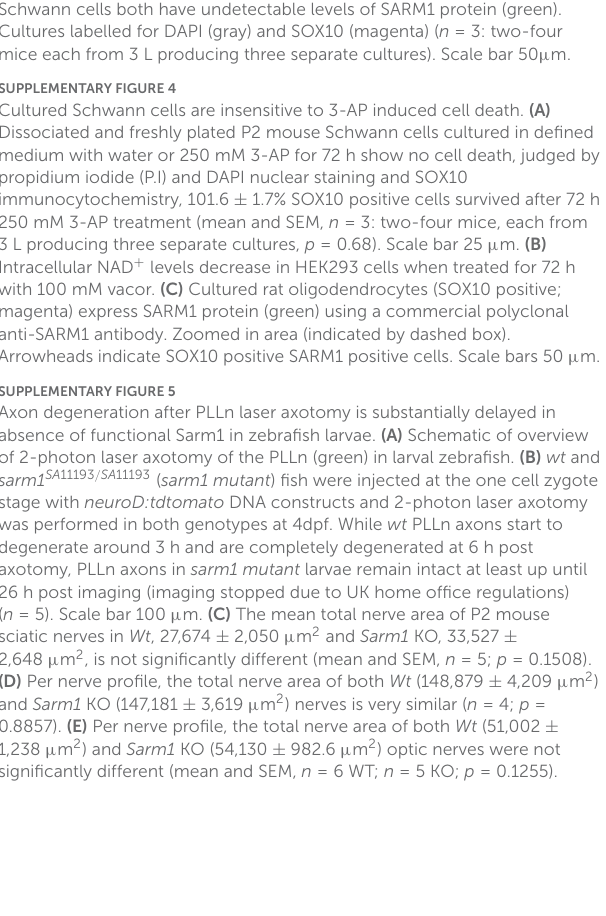
SUPPLEMENTARYFIGURE5 Axon degeneration after PLLn laser axotomy is substantially delayed in absence of functional Sarm1 in zebrafish larvae. (A) Schematic of overview of 2-photon laser axotomy of the PLLn (green) in larval zebrafish. (B) wt and sarm1 SA 11193 / SA 11193 ( sarm1 mutant ) fish were injected at the one cell